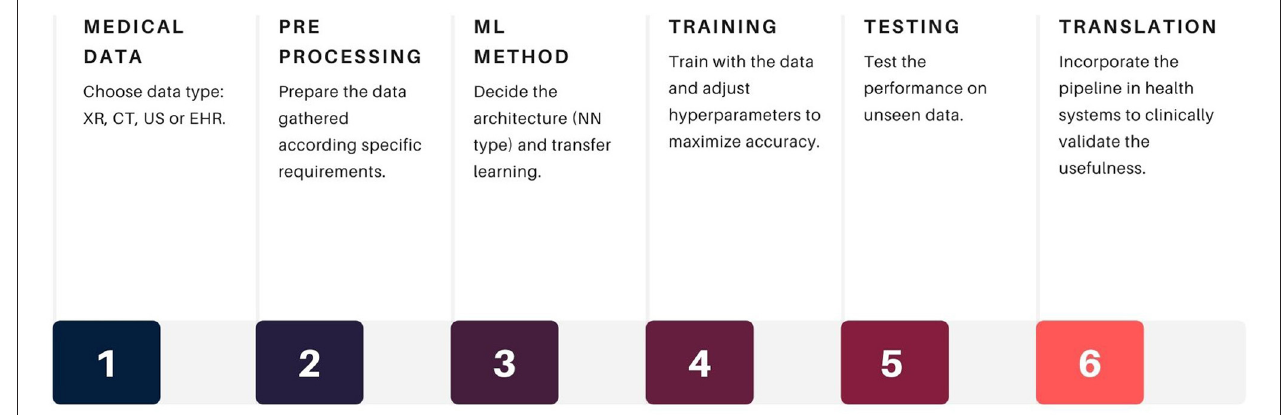
FIGURE 1 | General data pipeline for COVID-19 AI applications. Source: own ellaboration. References XR, x-rays; CT, computed tomography; US, ultrasound; EHR, electroninc health records.